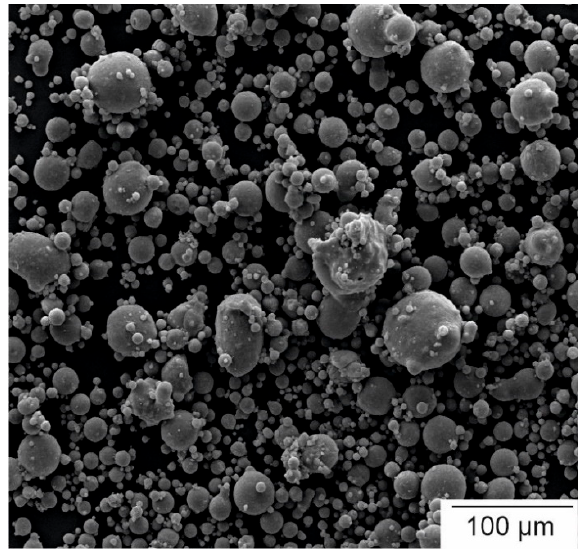
Figure 1. SEM image of the WE43 used for